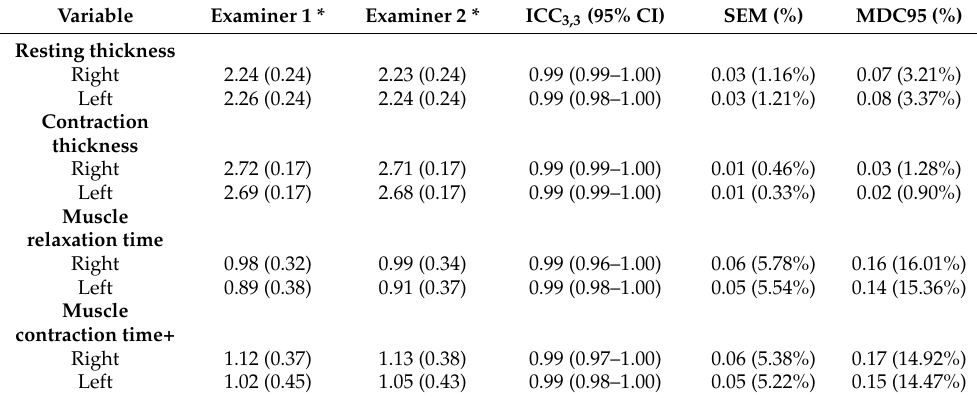
Table 2. Reliability of ultrasound